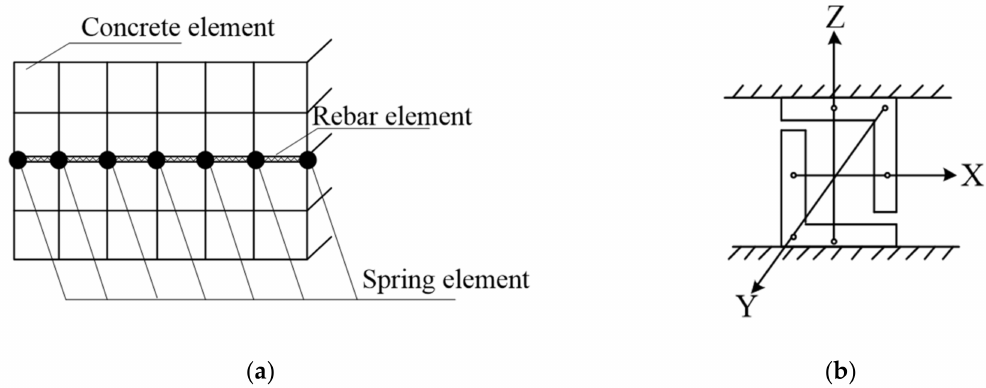
Figure 4. Illustration of spring element setting: ( a ) spring element setting; ( b ) spring